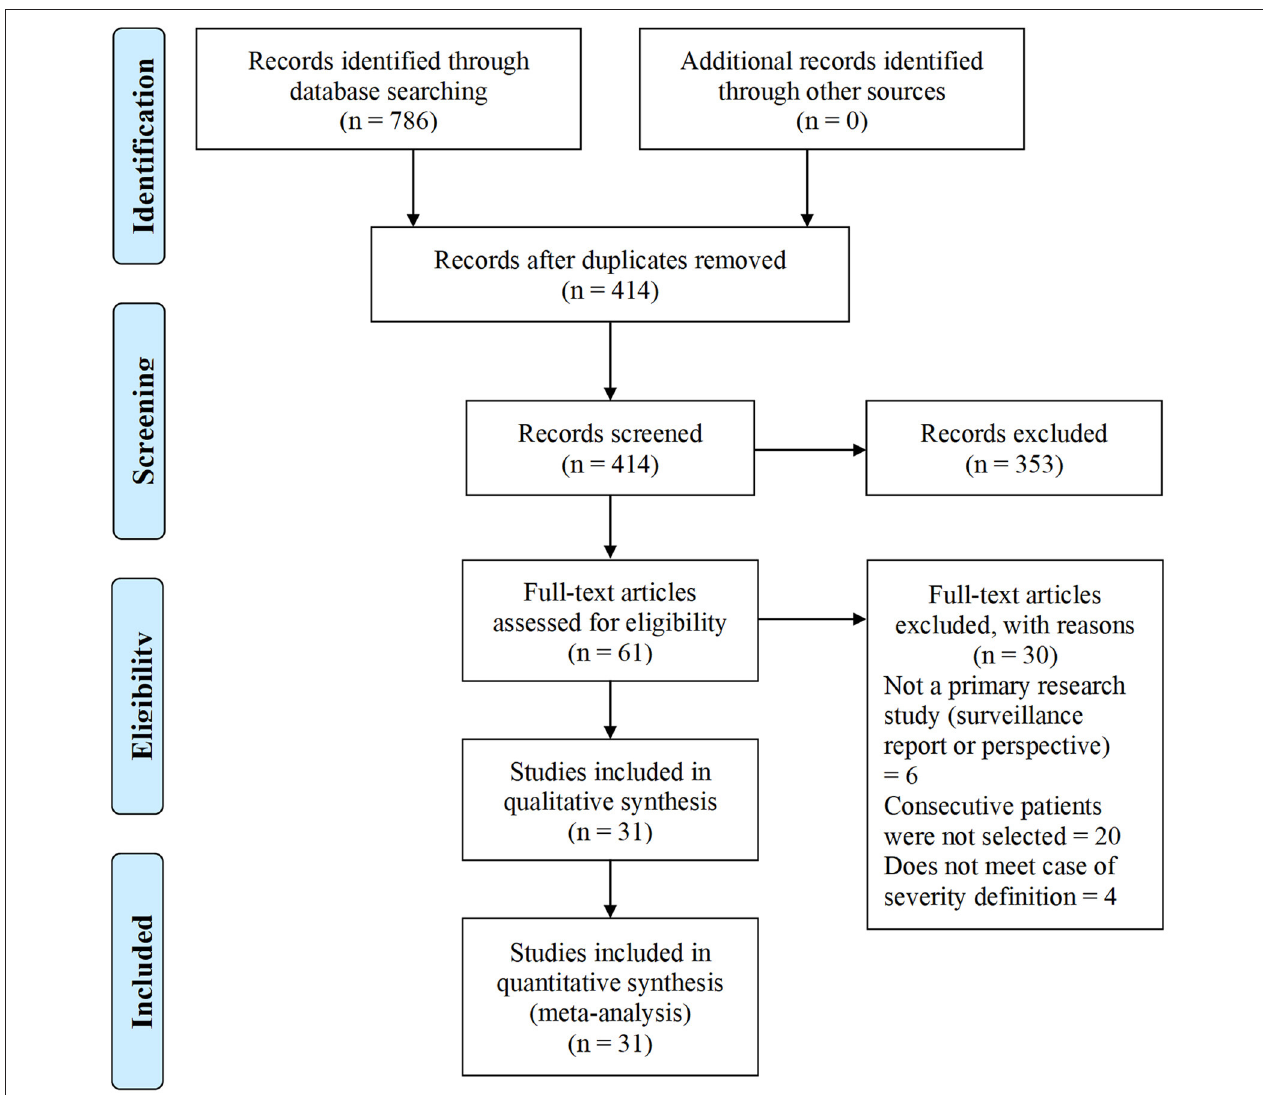
FIGURE 1 | COVID-19 sex-specific clinical outcomes flow diagram of the inclusion criteria of studies eligible for meta-analysis. Flow diagram template adopted from the PRISMA approach to meta-analysis